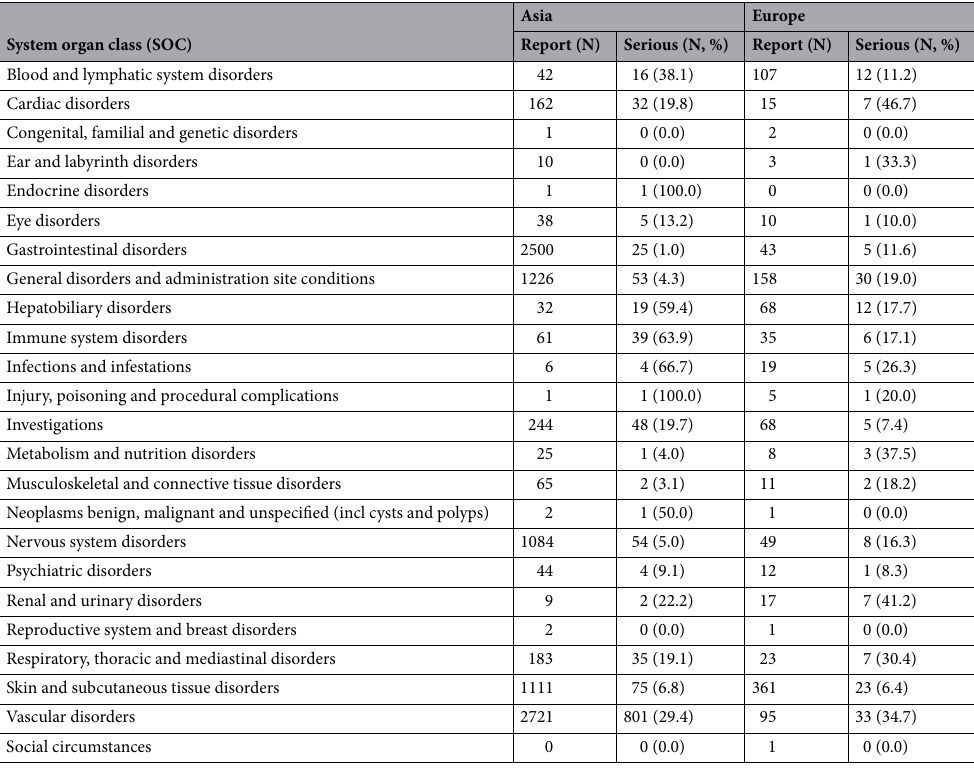
Table 2. Regional differences of propacetamol-related adverse events according to system organ class terms.